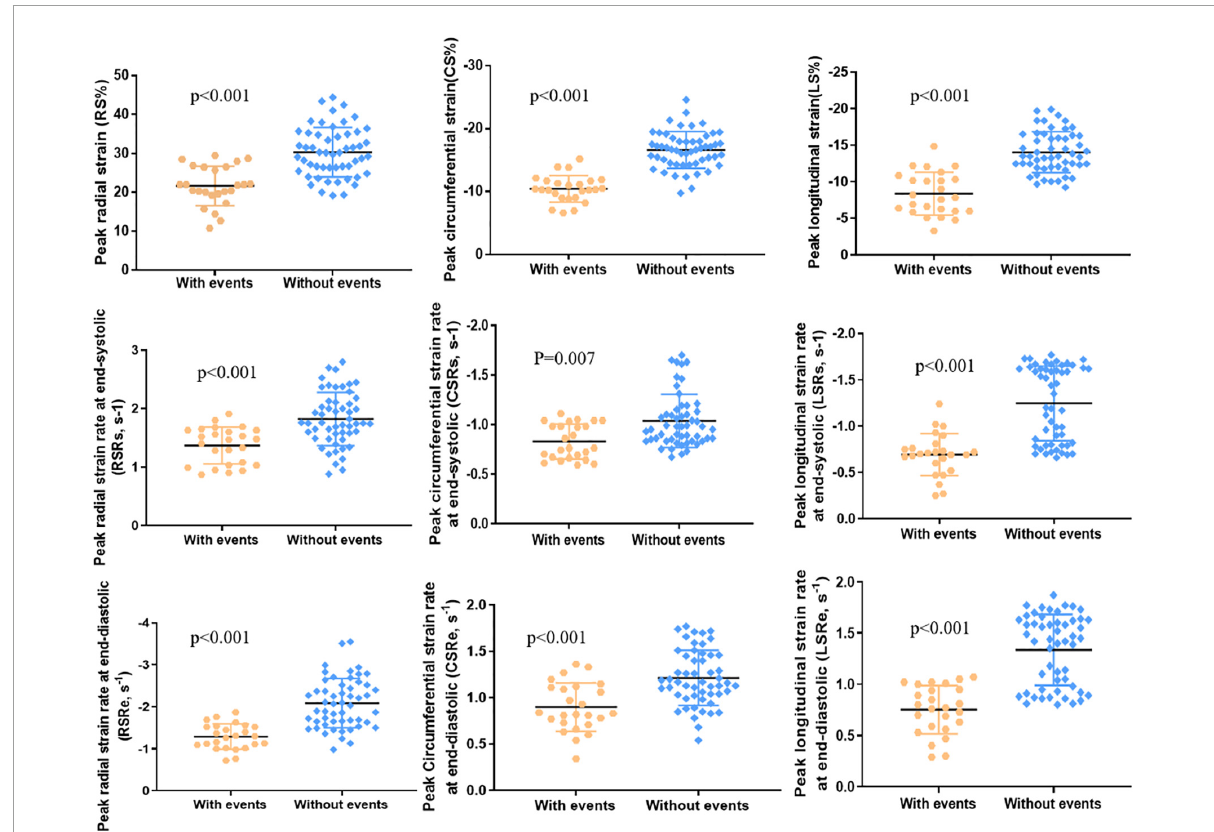
FIGURE3 LV peak radial strain (RS), peak circumferential strain (CS), peak longitudinal strain (LS), peak radial strain rate at end-systole (RSRs), peak circumferential strain rate at end-systole (CSRs), peak longitudinal strain rate at end-systole (LSRs), peak radial strain rate at end-diastole (RSRe), peak circumferential strain rate at end-diastole (CSRe), and peak longitudinal strain rate at end-diastole (LSRe) in patients with adverse events ( n = 25) and patients without adverse events ( n =